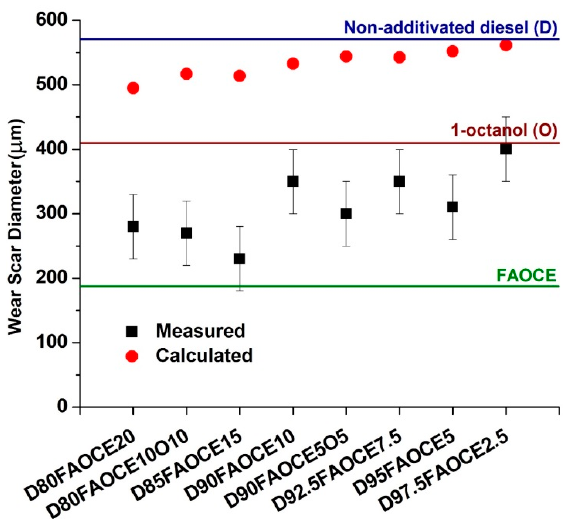
Figure 9. Wear scar diameter values of pure components and their binary and trinary blends with mineral diesel.